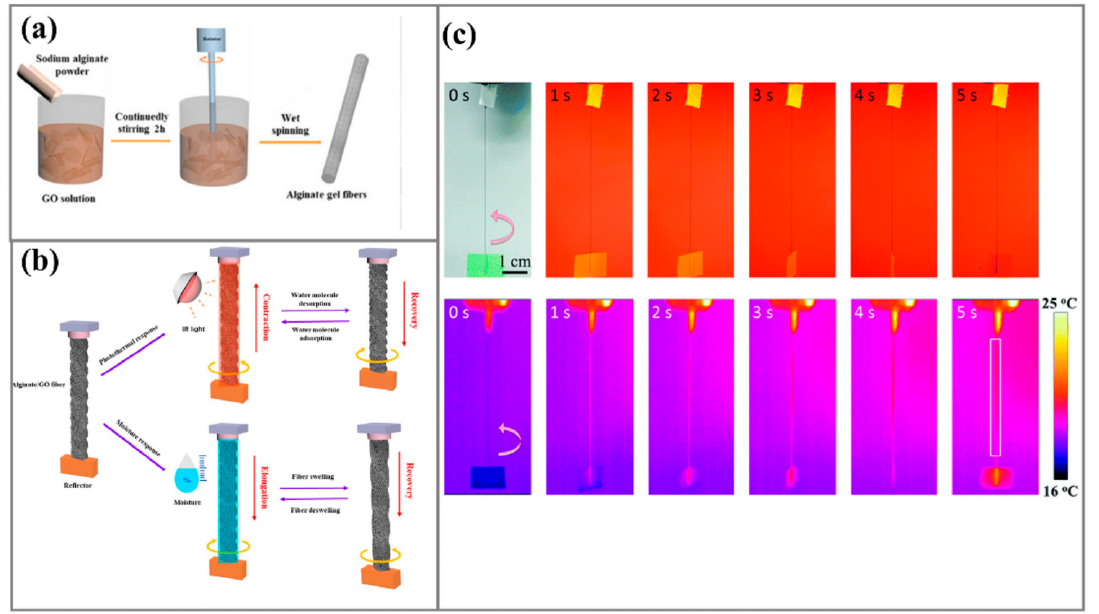
Figure 6. ( a ) Schematic diagram of the manufacturing process of the fiber-type actuator. ( b ) Schematic diagram of the reversible rotational motion of the twisted GO/SA fiber-based actuator under on/off light irradiation and moisture [87]. Permission from American Chemical Society. ( c ) Aspherical load produced a rapid forward and backward movement under on/off infrared light irradiation [78]. Permission from the Society.